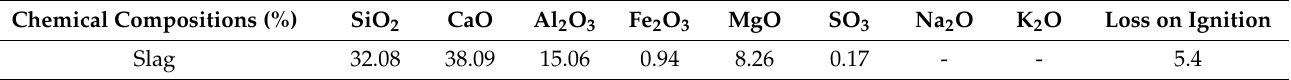
Table 5. Chemical compositions of slag.